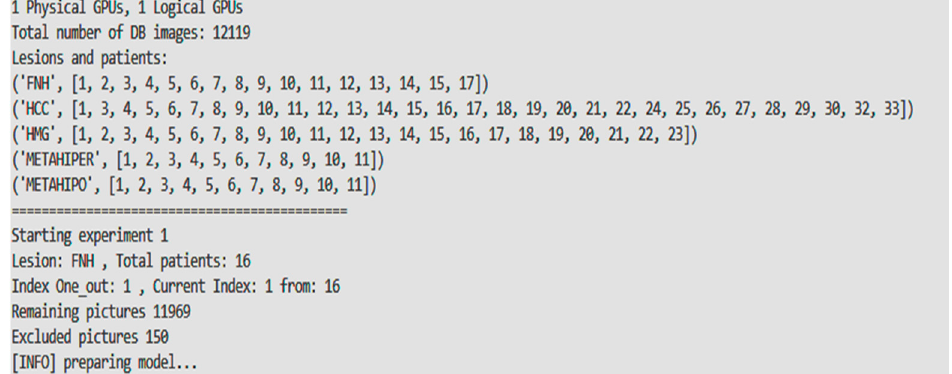
Figure 8. Transfer learning vs. train from scratch paradigm.